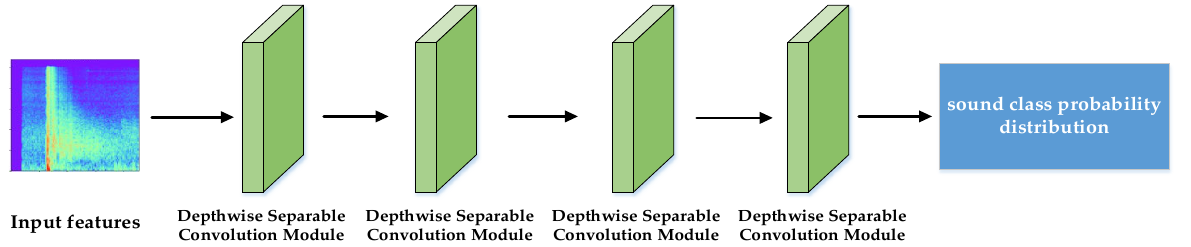
Figure 7. Schematic diagram of the student network structure.